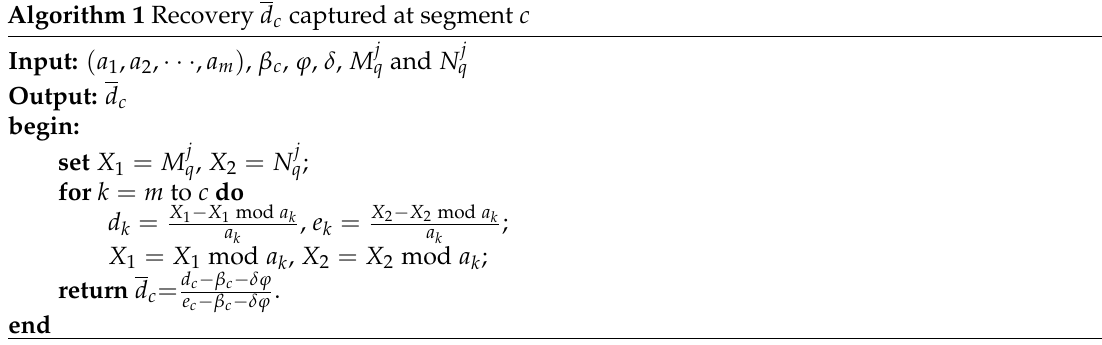
Algorithm 1 Recovery d c captured at segment